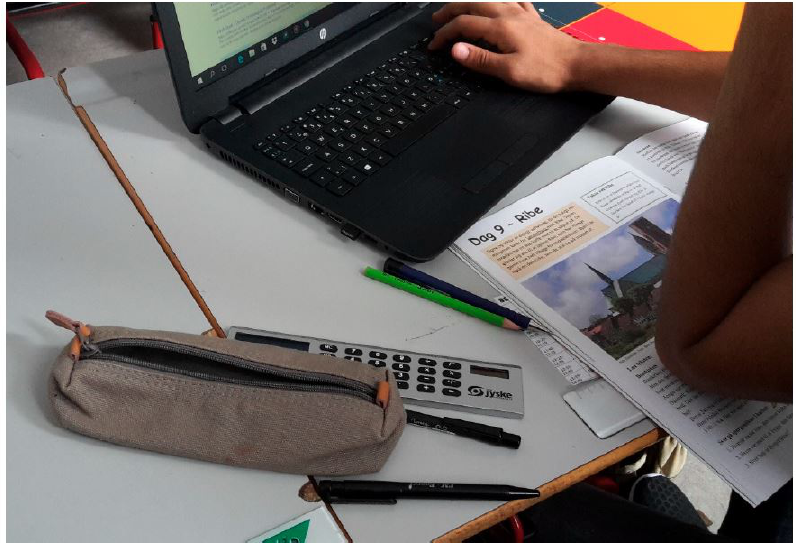
Figure 3. At school. One of the adolescents studying Danish (Source: Authors,